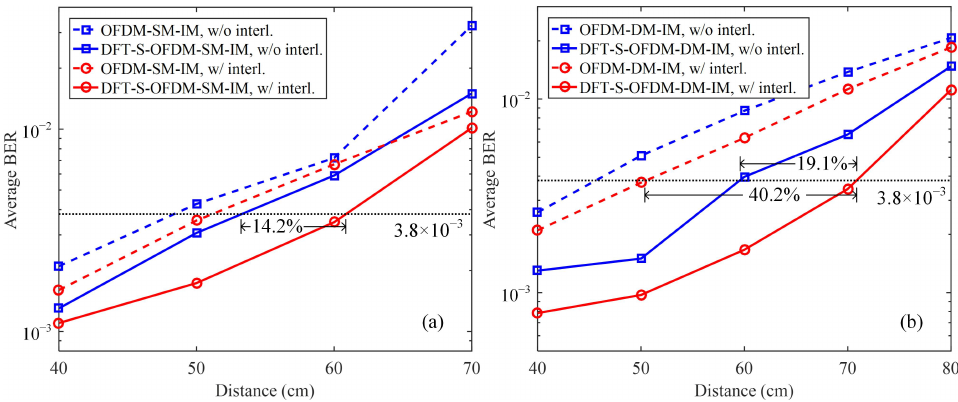
Figure 9. Average BER vs. distance for ( a ) OFDM-SM-IM and DFT-S-OFDM-SM-IM without and with interleaving and ( b ) OFDM-DM-IM and DFT-S-OFDM-DM-IM without and with interleaving (w/o: without, w/: with, interl.: interleaving).